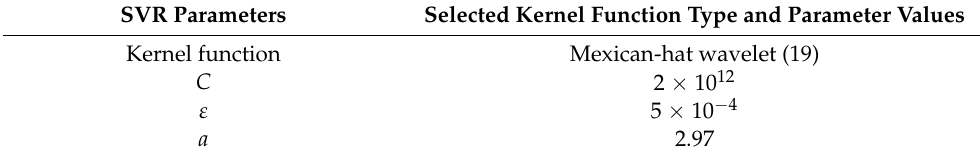
Table 2. SVR model